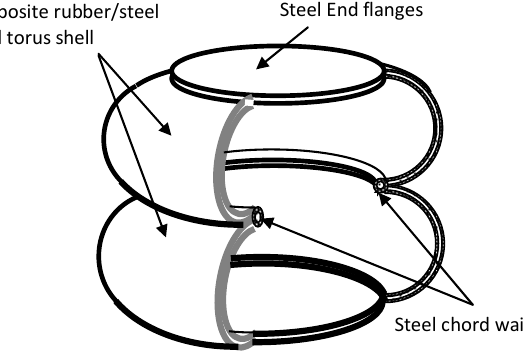
Figure 2. Double cell bellows air spring.